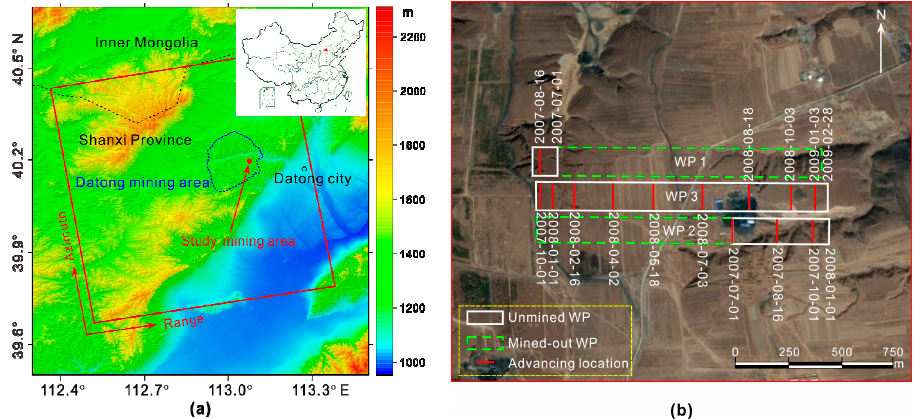
Figure 4. ( a ) Geographic location of the Datong mining area and the coverage of the SAR acquisitions superposed on the topographic relief shade map. ( b ) Advancing locations of the working panels from 1 July 2007 to 28 February 2009, overlain on the optical image acquired on 8 March 2014. The green dashed and white solid rectangles denote the mined-out and unworked working panels.